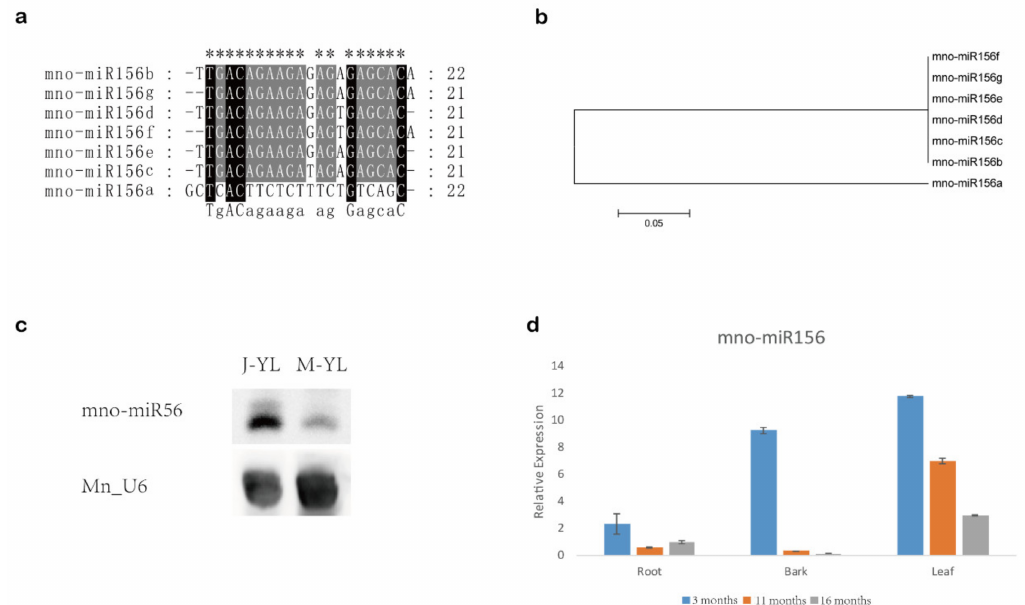
Figure 1. miR156 in mulberry. ( a ) Sequence alignment of miR156 in mulberry. “*” shows conserved sites. ( b ) Neighbor- joining (N.J.) phylogenetic tree of miR156 in mulberry. One thousand bootstrap replicates were used. ( c ) Northern blot showing the expression of miR156 in young leaves of juvenile (J.-Y.L.) and mature (M.-Y.L.) mulberry. Mn_U6 was used as a reference gene. ( d ) The expression profile of miR156 in three tissues (roots, bark, and leaves) at different time periods (3, 11, and 16 months) in mulberry. Values represent the mean ± SD from three biological